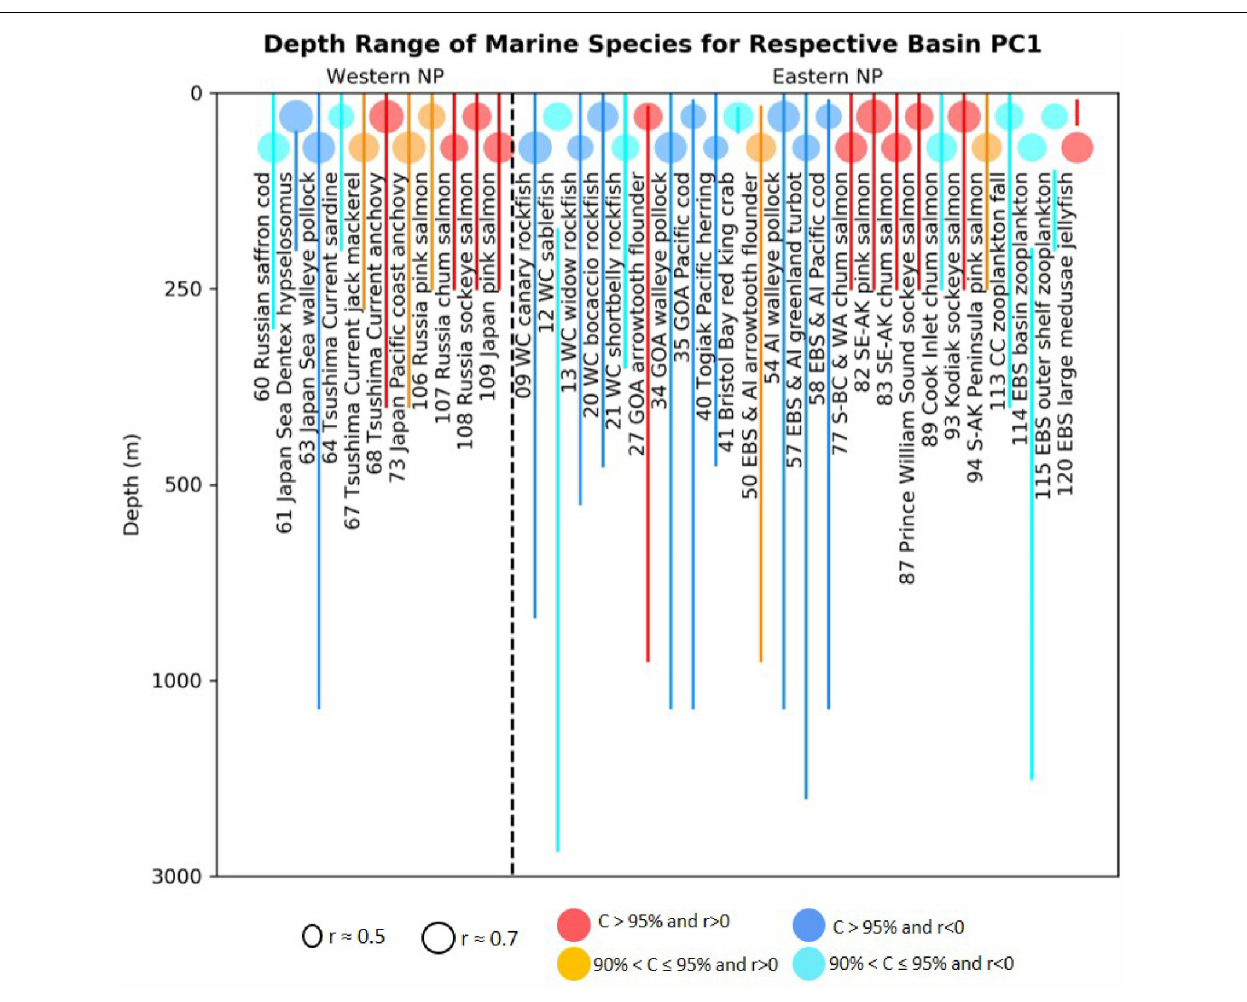
modes are generally opposite for shallow and deep-water